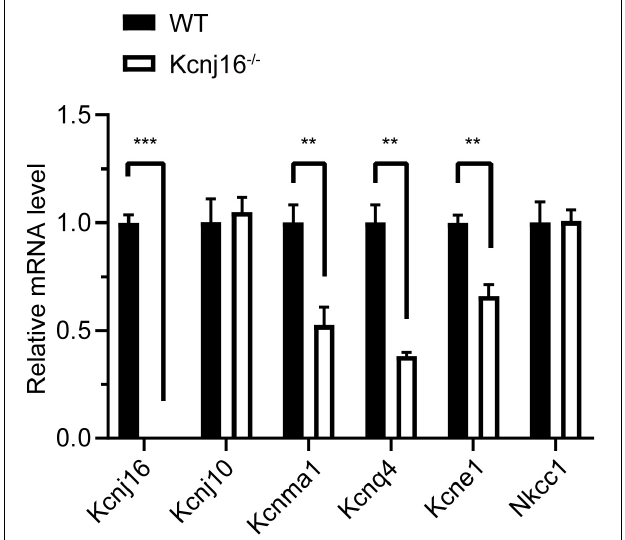
FIGURE 6 | The expression of Kcnma1 , Kcnq4 , and Kcne1 decreased in P30 Kcnj16 − / − mice. Q-PCR was performed with P30 WT and Kcnj16 − / − cochleae ( p < 0.05, n = 4). Primers are shown in the Supplementary Table 2 . Data are presented as the mean ± SD. ** p < 0.01, *** p < 0.001, n =